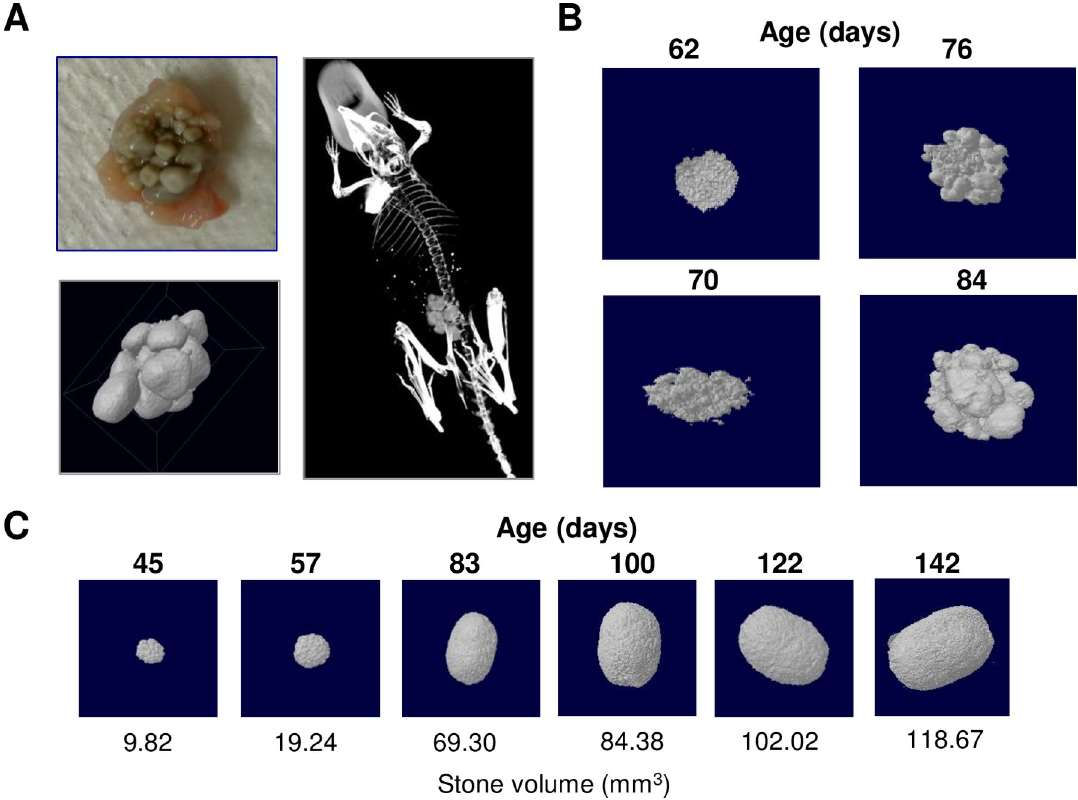
Fig 2. Stages of stone development. (A) μ CT imaging and 3D modeling of in vivo cystine stone development in a representative Slc3a1 -/- mouse. (B) μ CT imaging and 3D modeling of urinary stone growth in an individual Slc3a1 -/- mouse. Stone formation often initiates as sediment in the bladder (P62), and progresses through agglomeration (P70–76) to form urinary stones (P84); this progression can be seen here. (C) μ CT imaging and 3D modeling of a single stone’s growth in mm 3 over 142